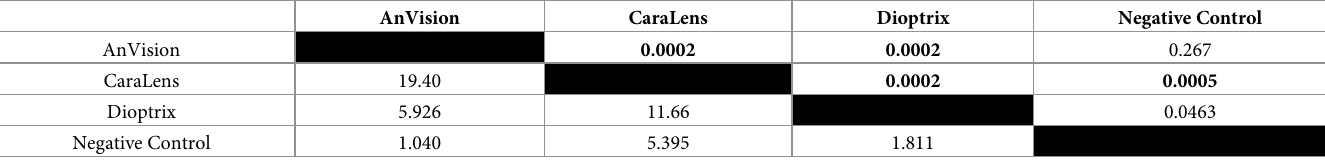
P-values (upper right) and F values (lower left) generated from one—way PERMANOVA of Bray Curtis similarity indices between microbial DNA detected in each of the brands and negative controls. ( p < 0.05)